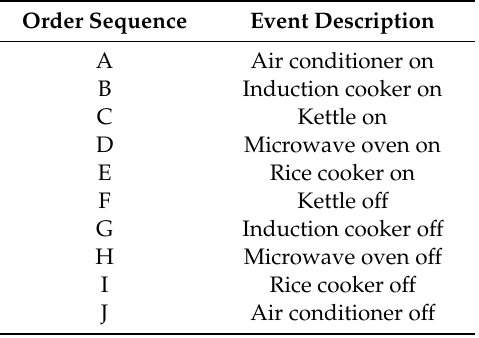
Table 3. Load event change point obtained by the original CUSUM